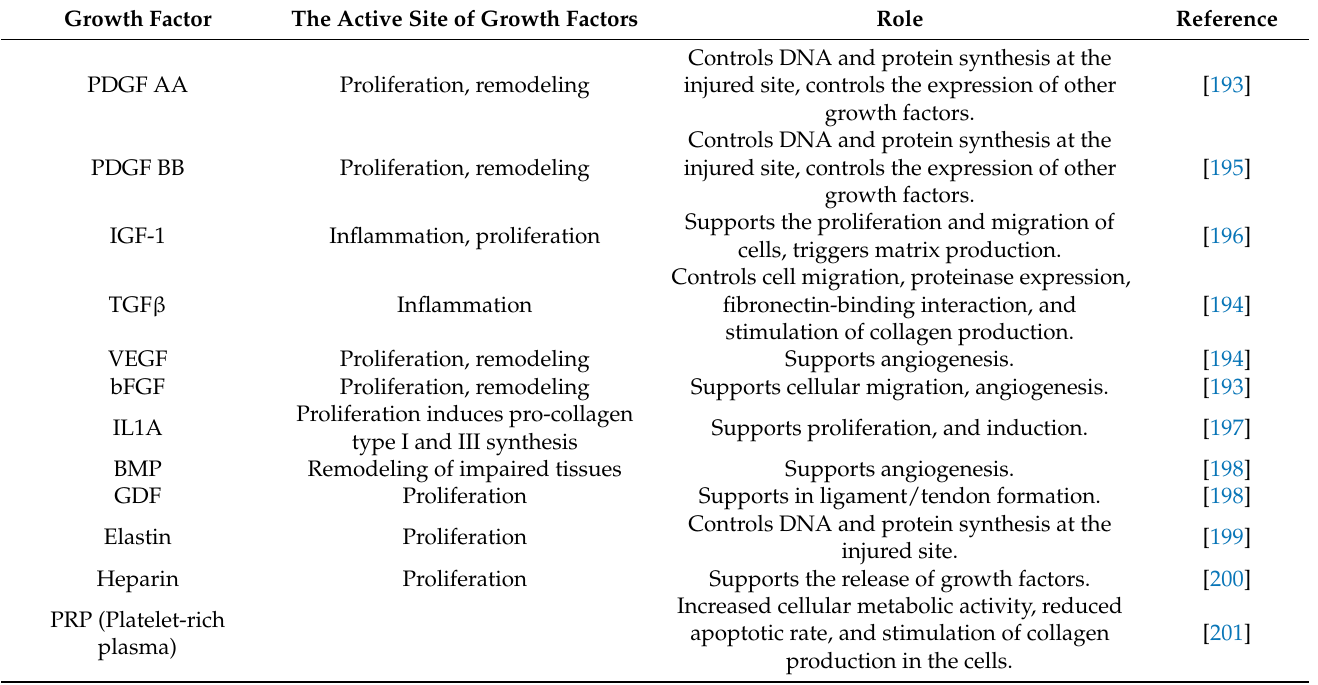
Table 13. A summary of the role of the seven growth factors during tendon and ligament